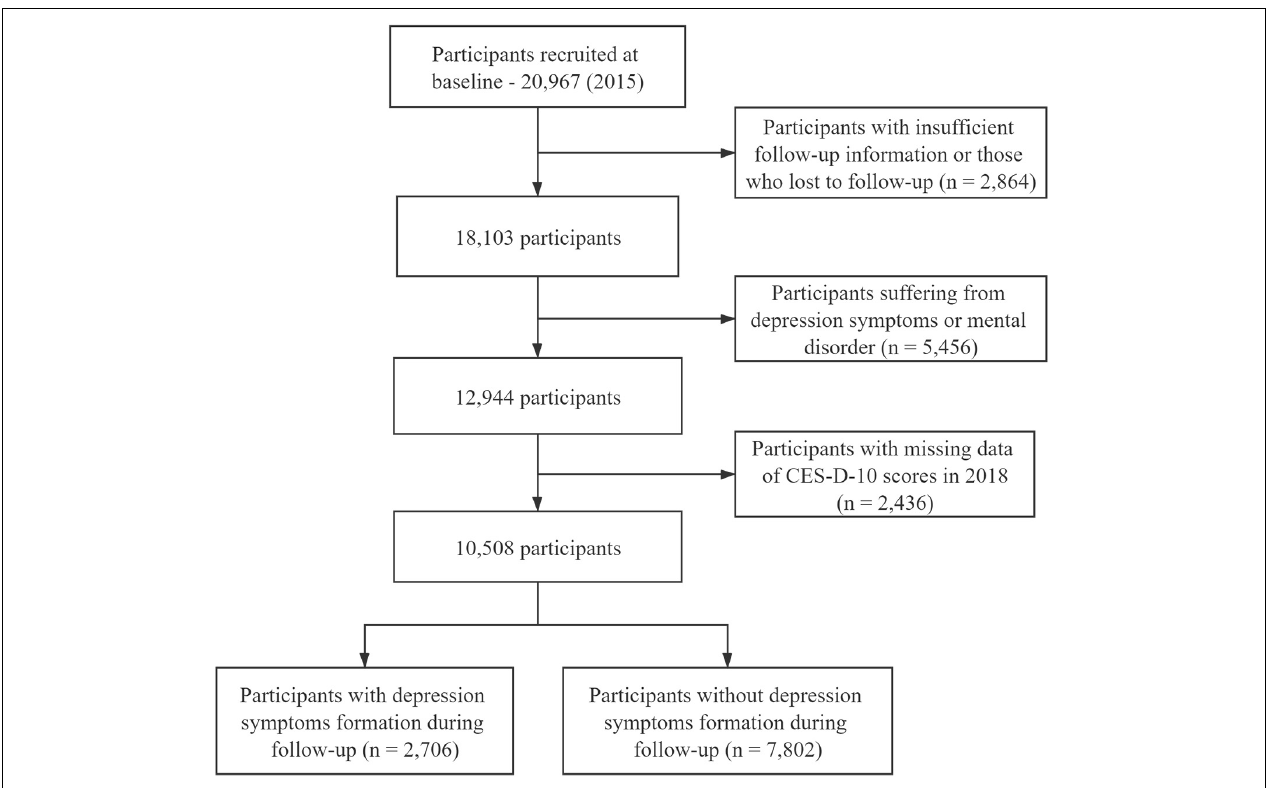
FIGURE 1 | Study flow chart using the data from CHARLS